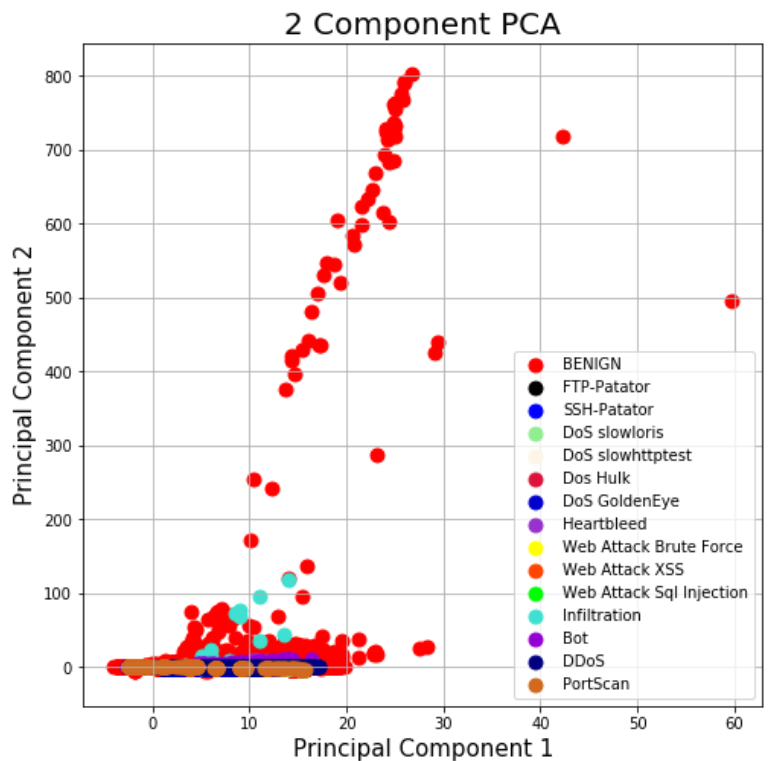
Figure 7. 2D Visualization of PCA on CICIDS2017 with original distribution.